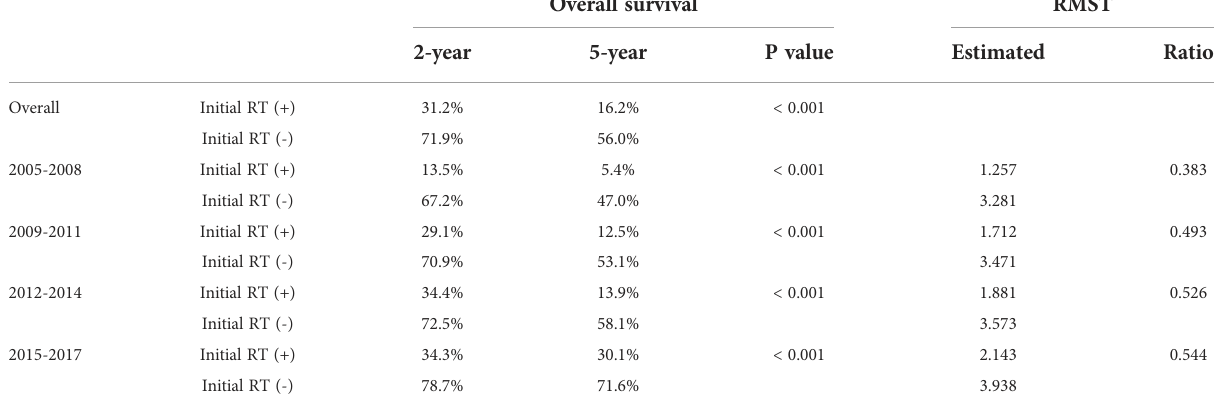
TABLE 2 Overall survival and RMST values of patients over